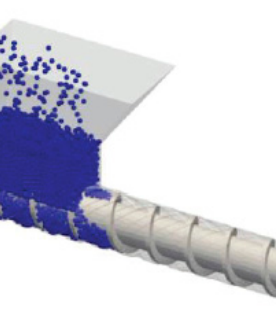
Figure 5. Overview of a DEM simulation of spherical particles—reprinted with permission from [22], with the permission of AIP Publishing.